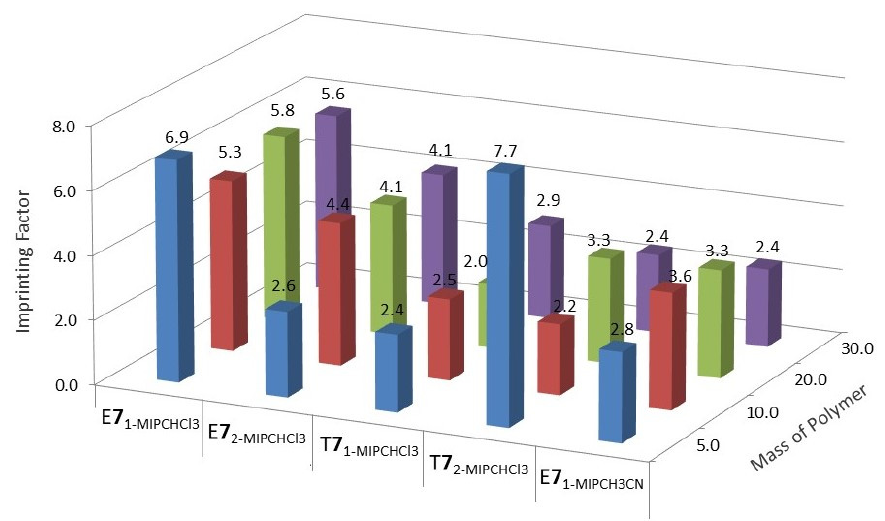
Figure 4. Imprinting factors (IFs) for the better-performing 1 -MIPs ( ≥ 2) from the set of formulations utilising 6, 7 and 12 as FMs, EGDMA and TRIM as XLs and CH 3 CN and CHCl 3 as porogens. Rebinding studies were conducted using 1 mL of 0.8 mM solution of benzylpiperazine in the original porogen, with the uptake measured after 30 min. All binding tests were performed in triplicate. The binding isotherms were generated by varying the rebinding solution concentra- tion of 1 between 0.5 and 10 mM, using a constant polymer loading of 20 mg and 60 min